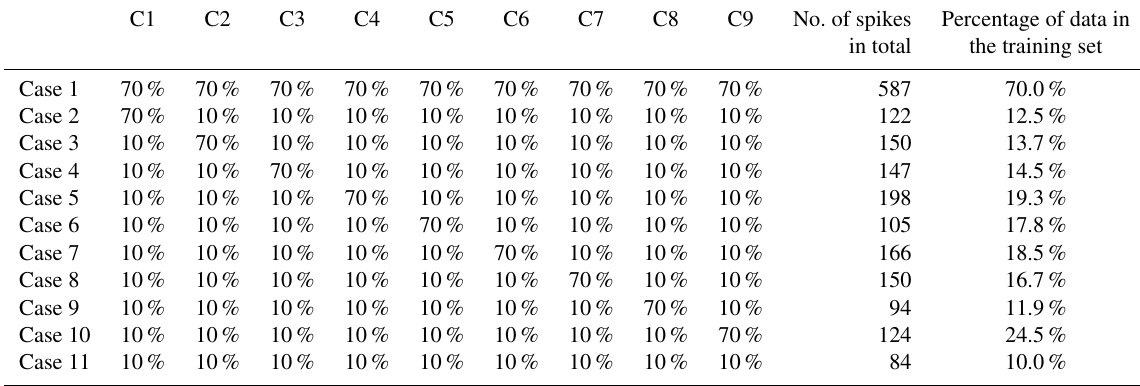
Table 2. Percentage of spikes in each cluster (C1 to C9) considered for training different